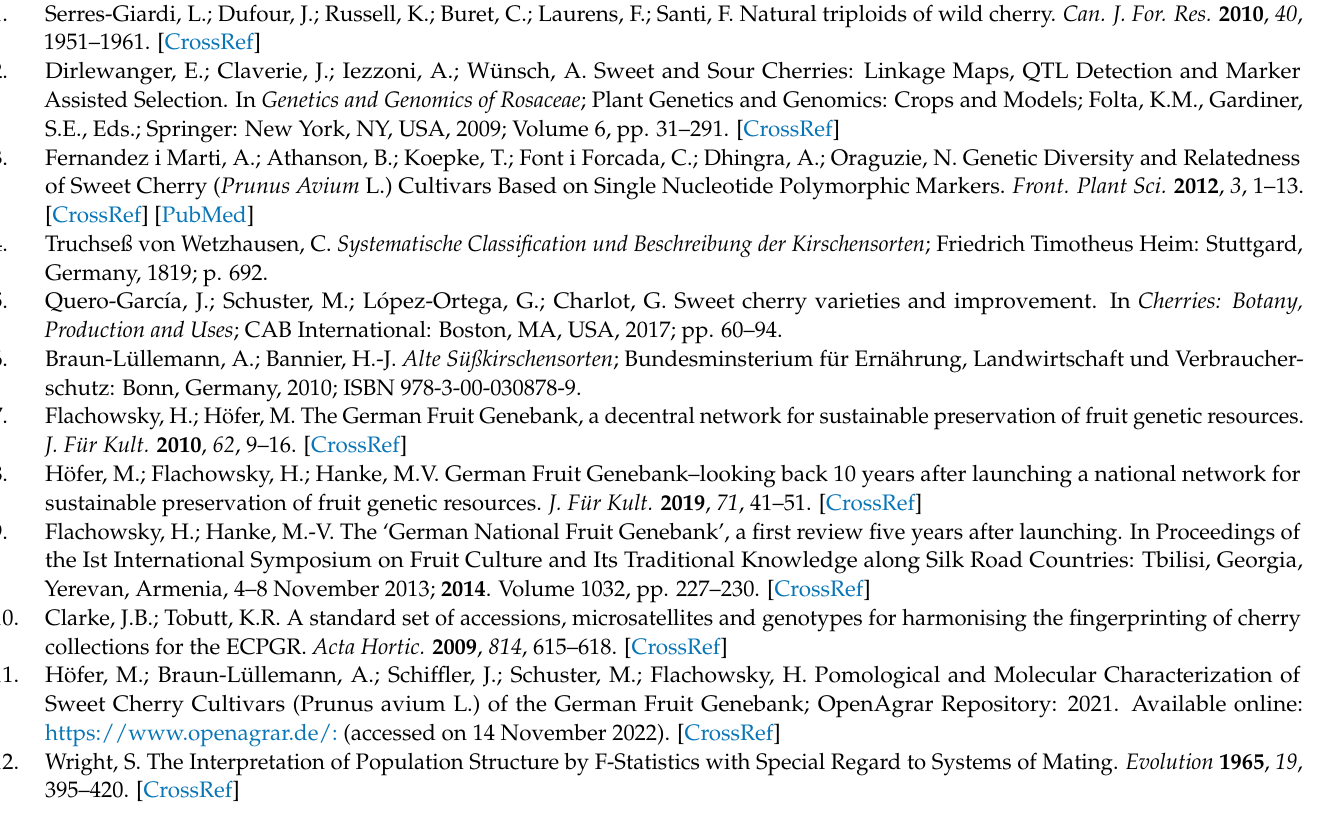
Figure S1: Dendrogram of the cherry cultivars investigated in this